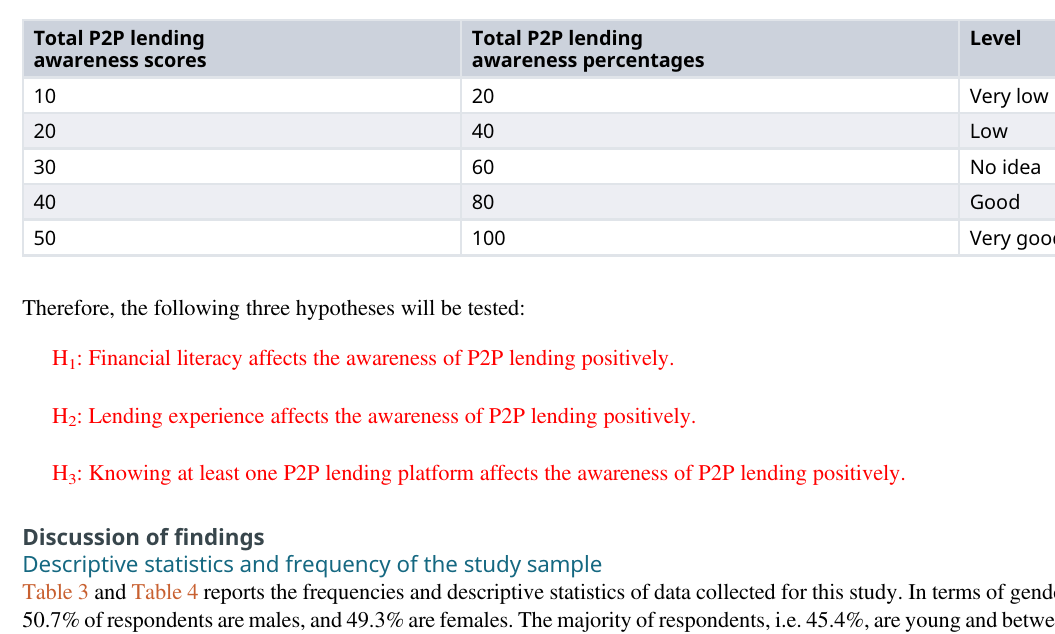
Table 2. Benchmarking scores and levels of P2P lending